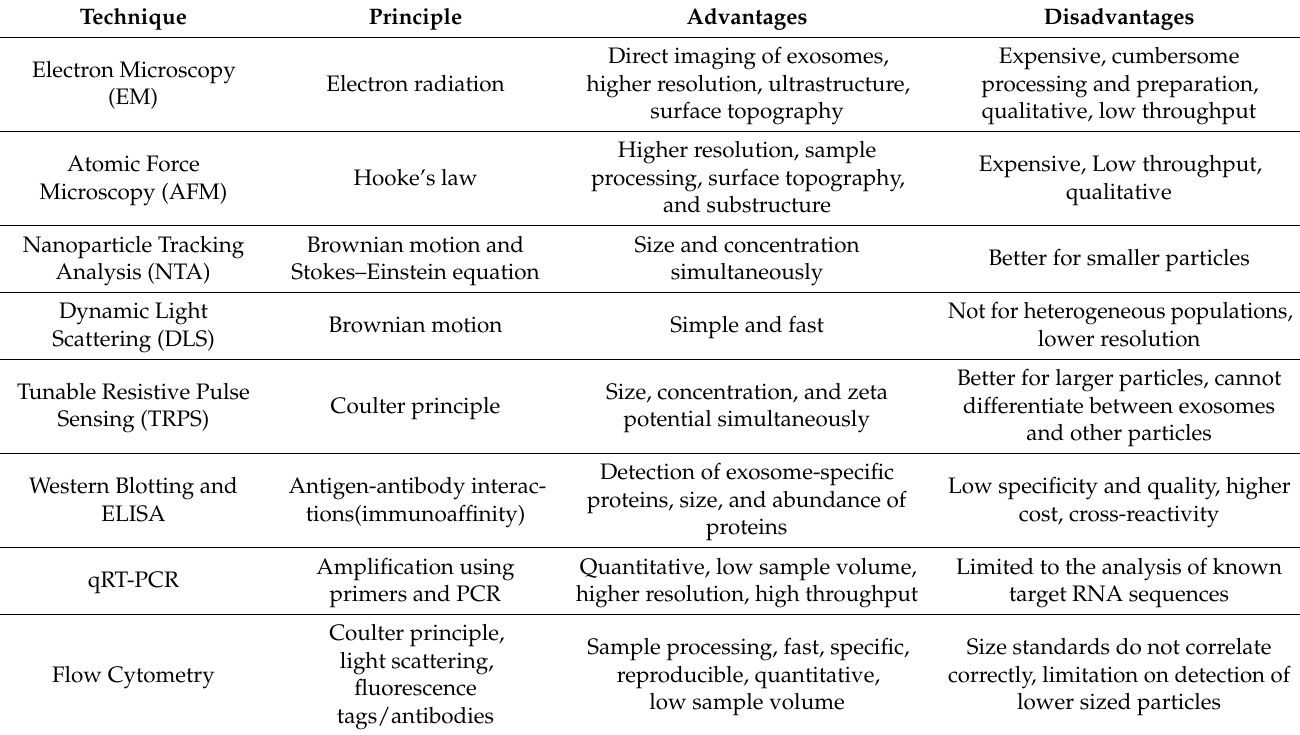
Table 2. Techiniques for characterization of